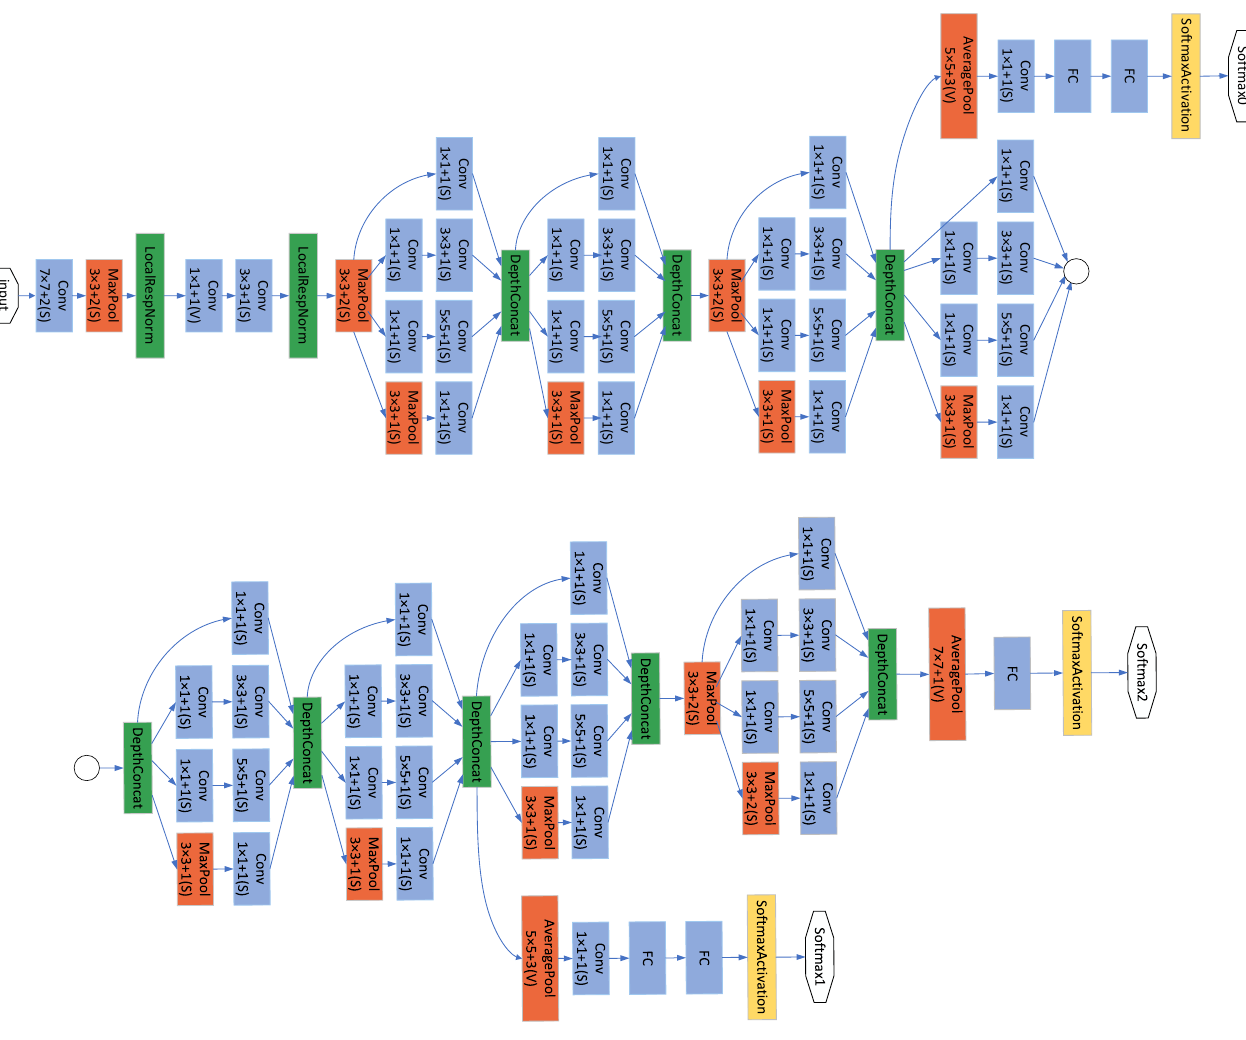
Figure 7. Image of GoogLeNet architecture. The circle connects the two parts of the figure.